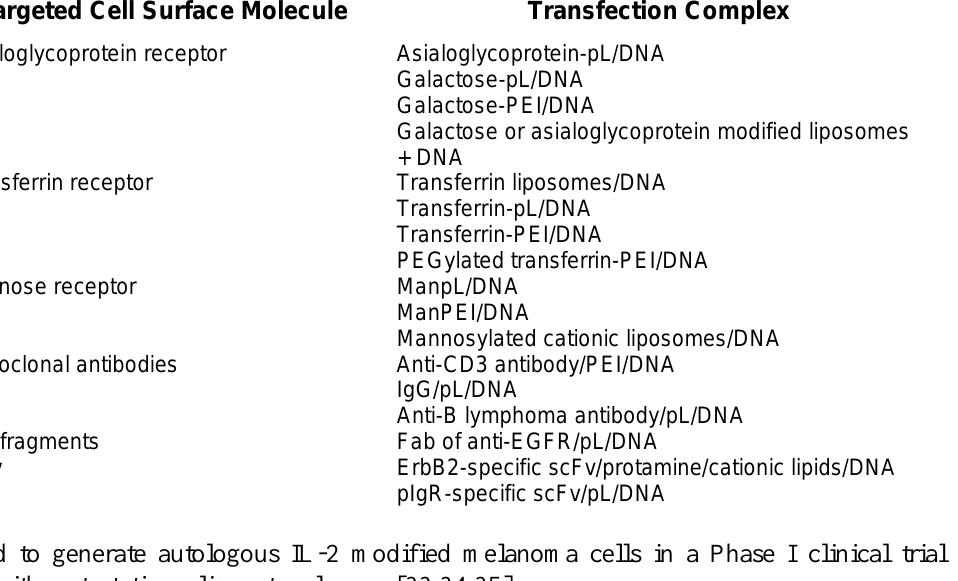
Gene Delivery Systems that Target Cell Surface Receptors and Other Cell